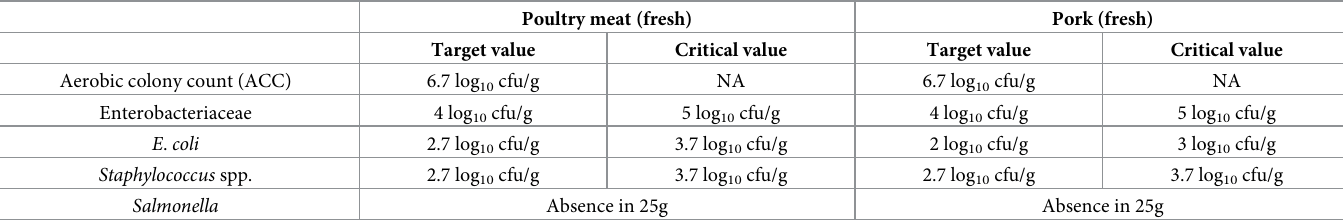
Table 1. DGHM microbial quality and safety criteria for fresh pork and poultry meat.